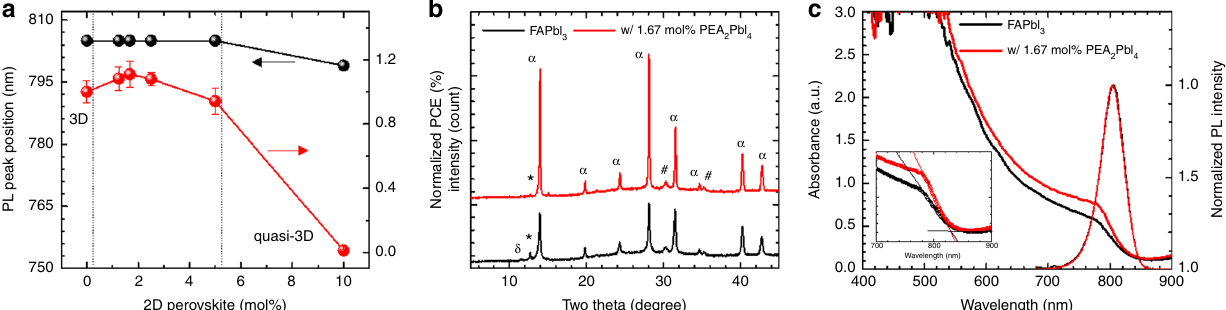
Fig. 1 Crystallographic and absorption properties. a Peak position for steady-state photolumimescence (PL) spectrum and normalized power conversion ef fi ciency (PCE) of the devices for FAPbI 3 perovskite with different amount of added 2D PEA 2 PbI 4 perovskite. The error bar of the normalized PCE indicates standard deviation of the PCEs. At least 10 devices were fabricated for each condition. b X-ray diffraction patterns, c absorption and normalized PL spectra of bare FAPbI 3 and FAPbI 3 with 1.67 mol% PEA 2 PbI 4 2D perovskite. Inset of c shows onset region of the absorption spectra with linear approximation (solid